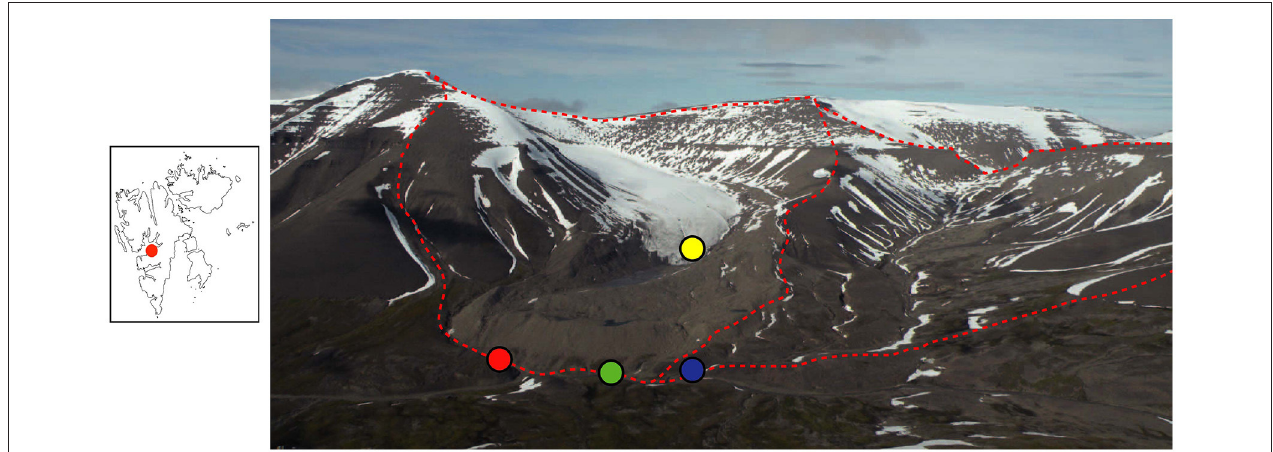
FIGURE 1 | Panoramic view of the two study catchments. Dryadbreen is on the left and Fardalen on the right. The red dashed line demarcates the catchment boundaries. Water sampling locations are indicated as follows: red circle, Dryadbreen; blue circle, Fardalen; green circle, valley stream; yellow circle, supraglacial sample. Note the large end moraine and sandur in the glaciated catchment. The red dot in the map on the left shows the location of the study area (Latitude, 78 ◦ 08 ′ N; Longitude, 15 ◦ 30 ′ E) in relation to the rest of Svalbard. Reprinted from Hindshaw et al. (2016a), Copyright (2015), with permission from